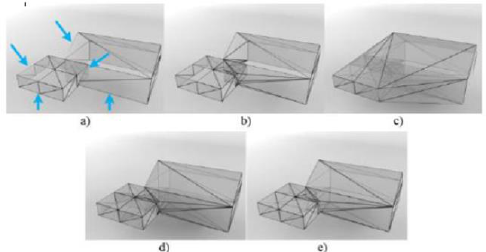
Figure 3 . Illustration of the Shrink-wrapping method (Zhao et al. 2013).